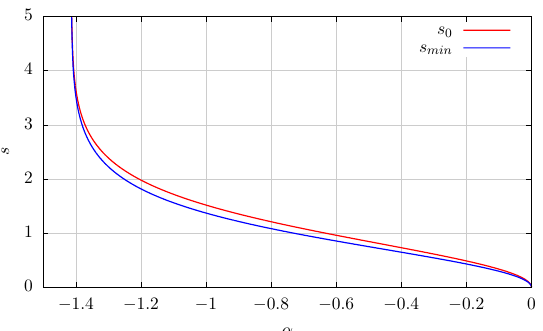
Figure 6 . The distance s between the antikinks and the central kink in the Q = (cid:0) 1 BPS solution, as a function of the impurity parameter (cid:11) . Blue line | the energy minimization. Red line | the integration of the BPS